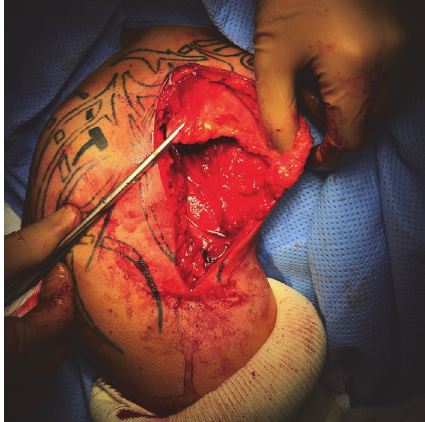
Figure 4: Intraoperative photograph demonstrating the gap between the footprint and the